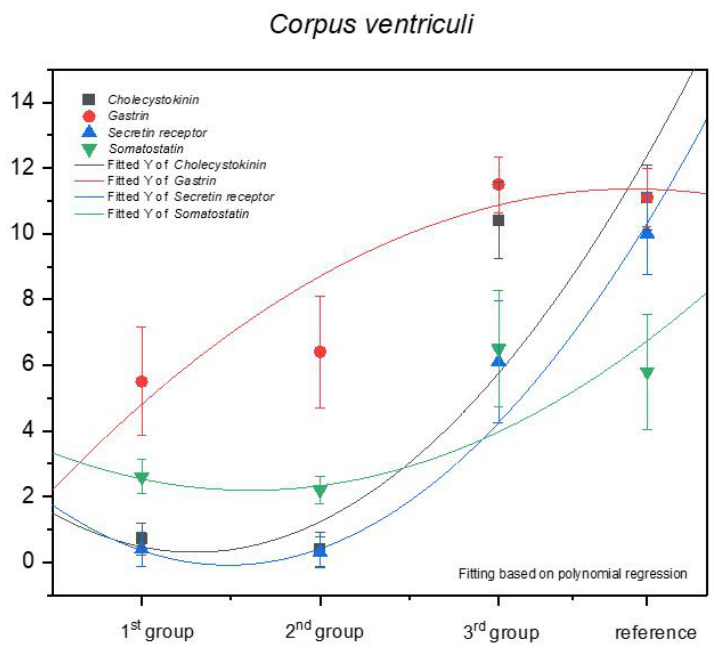
Figure 11. Expression of selected antibodies in the stomach of the investigated age groups. Contrary to the above mentioned findings, the immunohistochemical reaction for the other antibodies (anti-cholecystokinin, anti-secretin receptors, and anti-somatostatin) must be classified as negative allometric, especially in the first and second age group, approaching isometric in the third age group and the adult reference group. The regres- sion curves estimated for cholecystokinin and secretin receptor expression were similar to each other, and the one for somatostatin showed lower intensity. The increase in the expression of somatostatin was similar in the pyloric and fundic part of the stomach (negative allometric). The immunohistochemical reaction of the an- ti-secretin receptors showed a negative allometric increase only in the third age group and the adult reference group (Figure 12).